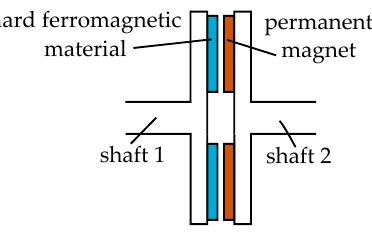
Figure 11. Cross-section of hysteresis torque limiter